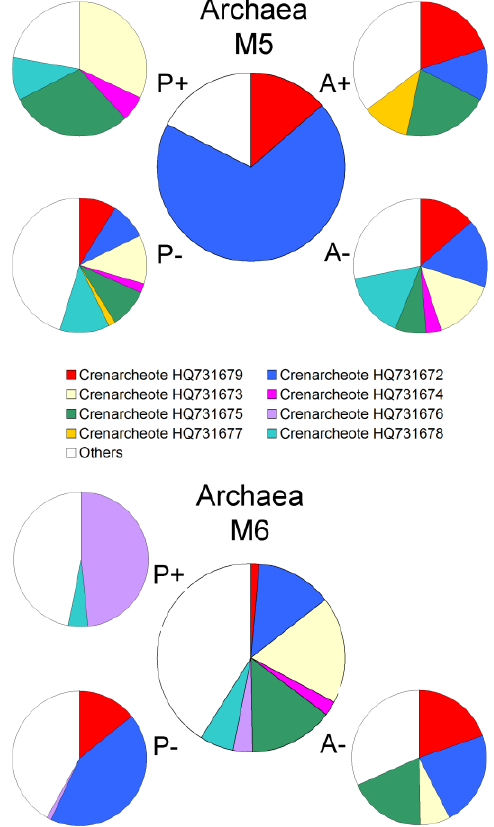
Figure 7. Changes in archaeal community structure in enrichment cultures. The percent contribution of sequenced DGGE bands to the total community. Relative abundance is derived from individual band intensities relative to the total sum intensity of all bands in the relevant lane The large central pie represents the pre-incubation community. P+: 42 MPa with nutrient; P (cid:237)(cid:29)(cid:3)(cid:23)(cid:21)(cid:3)(cid:48)(cid:51)(cid:68)(cid:3)(cid:90)(cid:76)(cid:87)(cid:75)(cid:82)(cid:88)(cid:87)(cid:3)(cid:81)(cid:88)(cid:87)(cid:85)(cid:76)(cid:72)(cid:81)(cid:87)(cid:30)(cid:3)(cid:36)(cid:14)(cid:29)(cid:3)(cid:36)(cid:87)(cid:80)(cid:82)(cid:86)(cid:83)(cid:75)(cid:72)(cid:85)(cid:76)(cid:70)(cid:3)(cid:83)(cid:85)(cid:72)(cid:86)(cid:86)(cid:88)(cid:85)(cid:72)(cid:3)(cid:90)(cid:76)(cid:87)(cid:75)(cid:3)(cid:81)(cid:88)(cid:87)(cid:85)(cid:76)(cid:72)(cid:81)(cid:87)(cid:30)(cid:3)(cid:36)(cid:237)(cid:29)(cid:3) Atmospheric pressure without nutrient. No bands were sequenced from the M6 A+